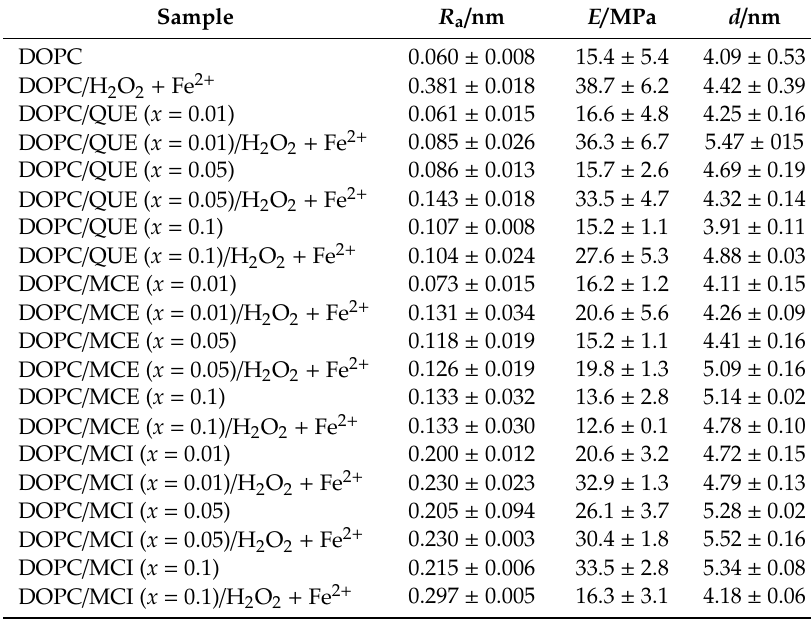
Table 2. The e ff ect of the insertion of flavonols and induced lipid peroxidation on the roughness ( R a ), Young’s Modulus ( E ), and bilayer thickness ( d ) of the model DOPC SLB (n =